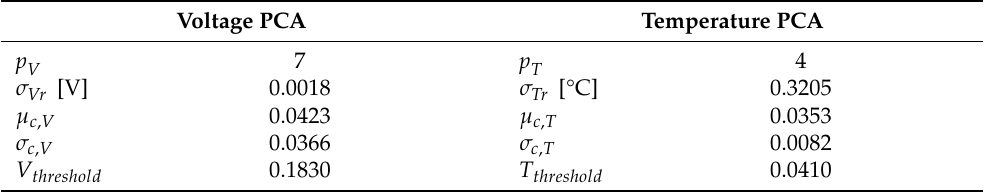
Table 1. Outputs from training process in PCA